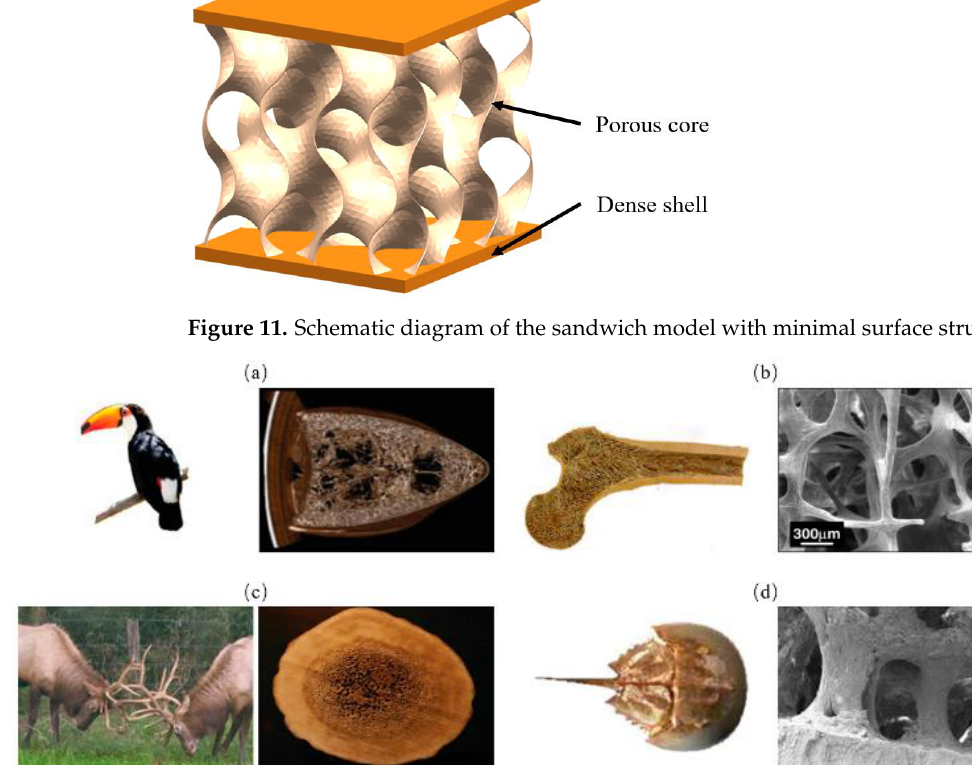
Figure 12. Sandwich model in biological organisms. ( a ) toucan beak [62] Copyright©2005, Acta Ma- terialia ( b ) human trabecular bone [51] Copyright©2007, Progress in Materials Science ( c ) antler [63] Copyright©, 2010Acta Biomaterialia. ( d ) horseshoe crab [64]. Copyright©2018, Progress in Materials